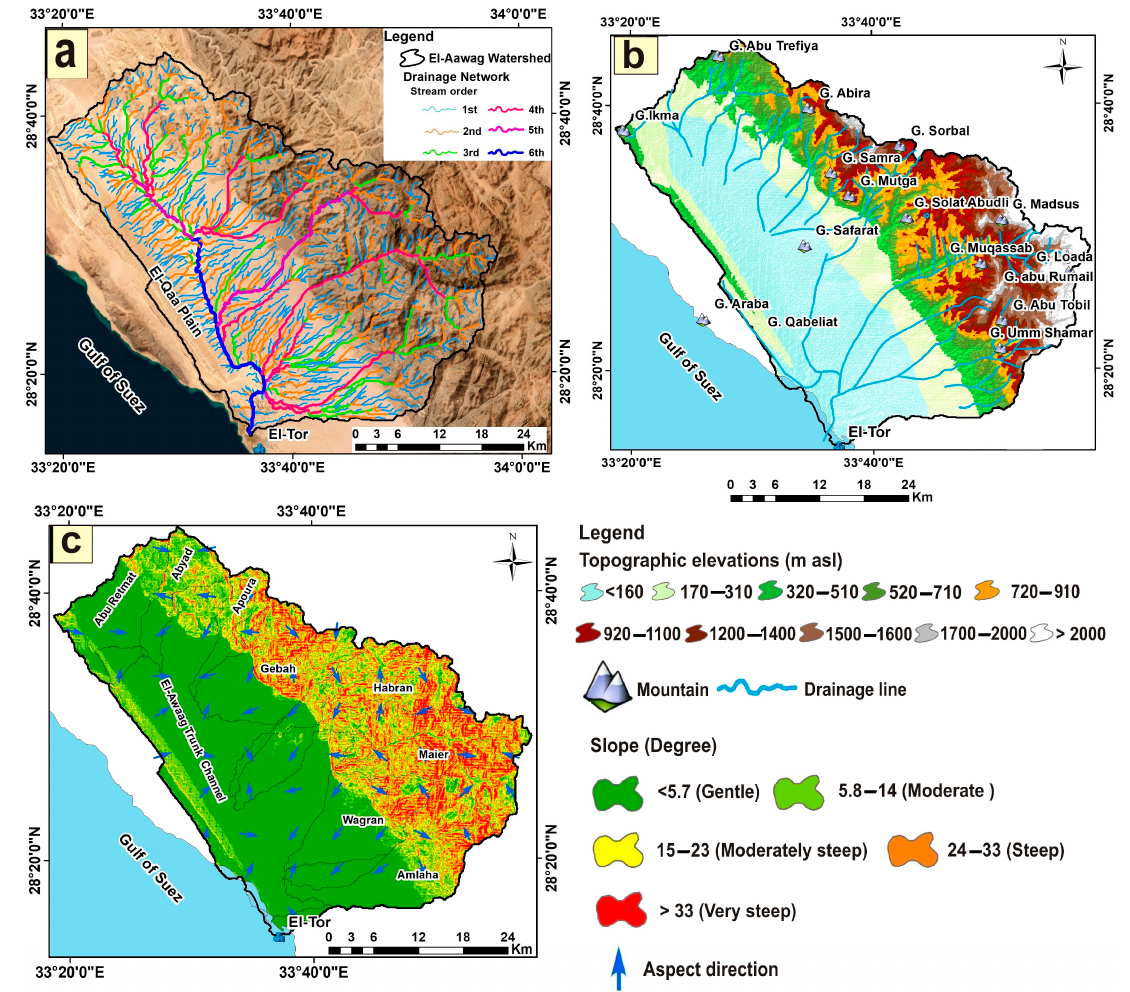
Figure 2. El-Aawag Watershed: ( a ) Spot 4 satellite image and drainage network; ( b ) orographic features and topographical elevations (based on an accuracy of 30 m ASTER DEM); ( c ) slope degree and the names of the sub-basins.